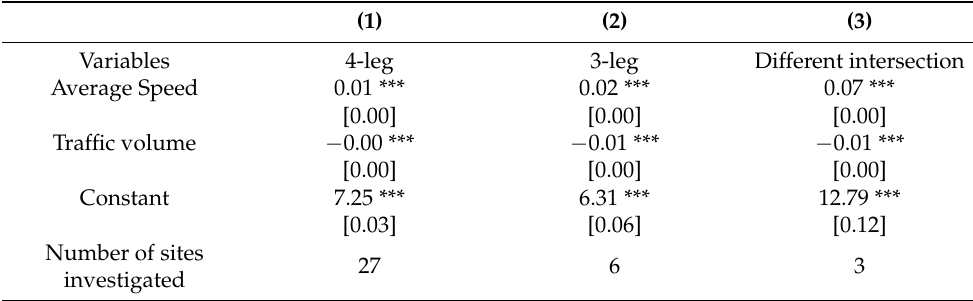
Table 7. Relationship between red light violation and traffic